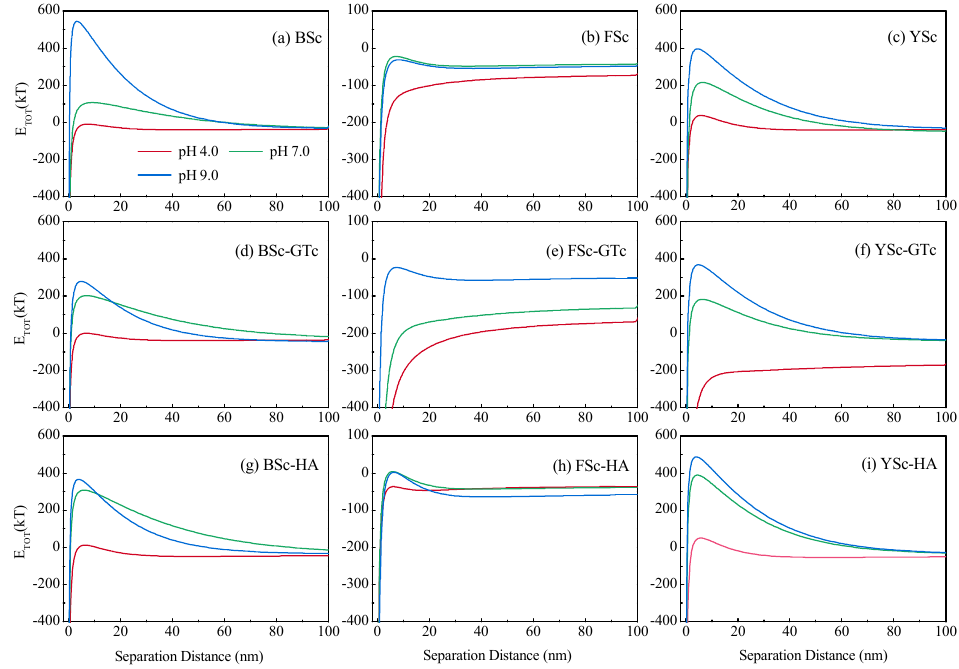
Figure 3. DLVO interaction energy (E TOT ) of soil colloids versus ( a ) black soil (BS) colloids, ( b ) fluvo-aquic soil (FS) colloids, ( c ) yellow soil (YS) colloids, ( d ) BS–goethite (GT), ( e ) FS–GT, ( f ) YD–GT, ( g ) BS–humic acid (HA), ( h ) FS–HA, and ( i ) YS–HA at pH 4.0 (red lines), 7.0 (green lines), and 9.0 (blue lines). The E TOT is expressed in kT, where k is the Boltzmann constant and T is the absolute temperature in Kelvin.